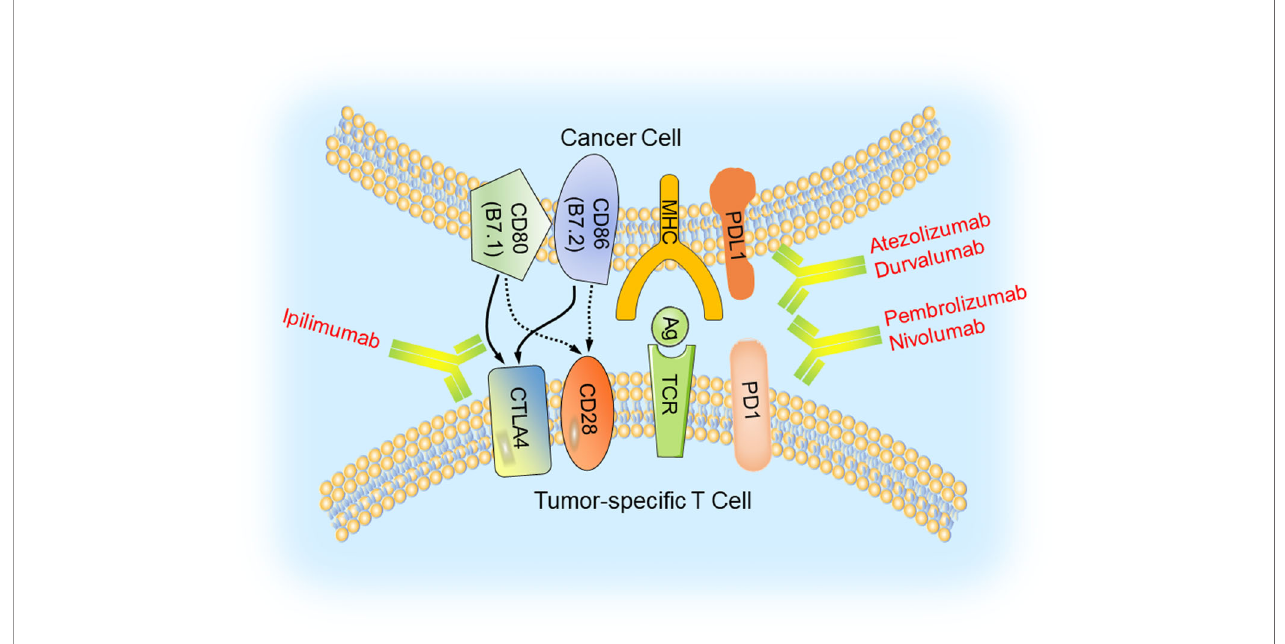
FIGURE 2 | Immune checkpoint blockade in TNBC. Major histocompatibility complexes (MHCs) are antigens on the surface of the cancer cell for recognition by the cytotoxic T lymphocyte (CTL) via the TCR. The binding of PD1 on the surface of the CTL with its ligand PDL1 functions to suppress the activation of the CTL, leading to its cell death. CTLA4 is another inhibitory immune checkpoint molecule expressed on CTL. Antibodies (anti-CTLA4/ipilimumab, anti-PD1/pembrolizumab and nivolumab, anti-PDL1/atezolizumab and durvalumab) inhibit these immune checkpoint proteins to restore the activity of CTLs and kill cancer